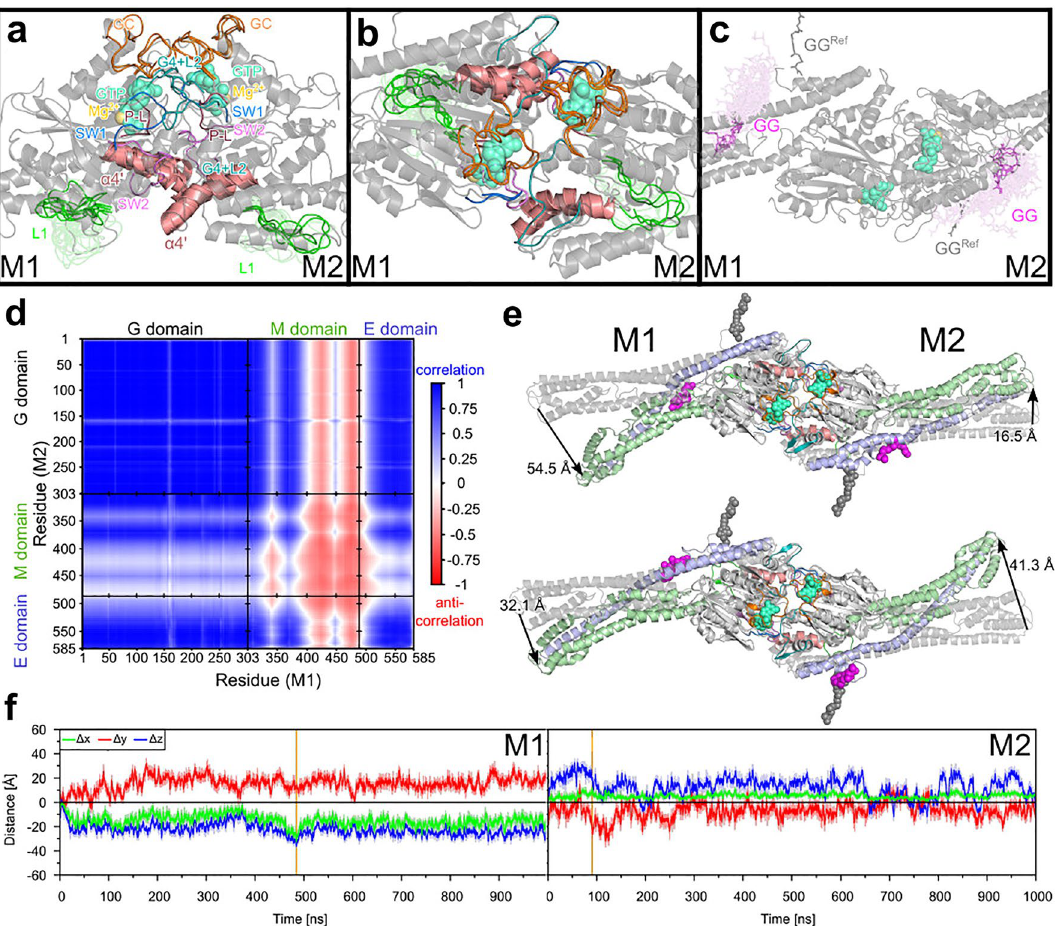
Figure 6. Molecular motions in the mGBP2 holo dimer obtained from a 1 µ s MD simulation. Conformational clusters of the G-domain motifs, the L1, and the guanine cap in the side view ( a ) and front view ( b ). In ( c ) the clusters of the geranylgeranyl lipid anchor (GG) are shown. The same coloring scheme as in Fig. 3 was used. ( d ) The dynamic cross-correlation between the motions of the C α atoms of M1 and M2 is shown. Blue and red colors represent correlation and anti-correlation, respectively. Uncorrelated motions, corresponding to the value 0, are shown in white, and correlation values of < | 0.5 | can be considered insignificant. The different domains are separated by black lines and the domain names given on the axes. ( e ) The largest deviations from the start structure as sampled in the MD simulation are depicted, and the amplitudes (in Å) for the tip of the M/E domain are given. ( f ) The motions of residue L480 relative to the start structure of the MD simulation are quantified in terms of (cid:31) x (green), (cid:31) y (red), and (cid:31) z (blue) in M1 (left panel) and M2 (right panel) after aligning the trajectory on the G domain of protein M1 and using the same coordinate definition as shown in Fig. 5. The solid lines display the running average and the shades illustrate the raw data. The zero line is shown in black, whereas the vertical orange line indicates the frame with the maximal distance of the L480 residue between reference structure and the